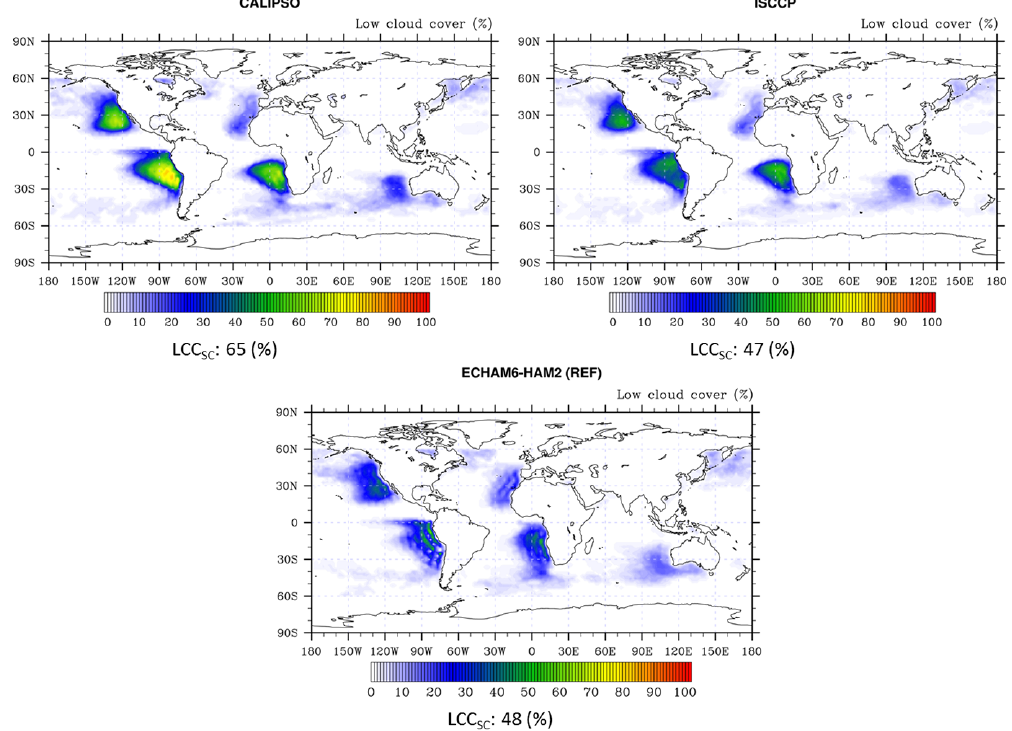
Figure 5. Low-level cloud cover in stratocumulus cloud regions in the reference simulation and the CALIPSO and ISCCP satellite data. Values below each panel show in-regime values (subscript Sc ) . Note that in-regime values are larger than the mean over the stratocumulus cloud